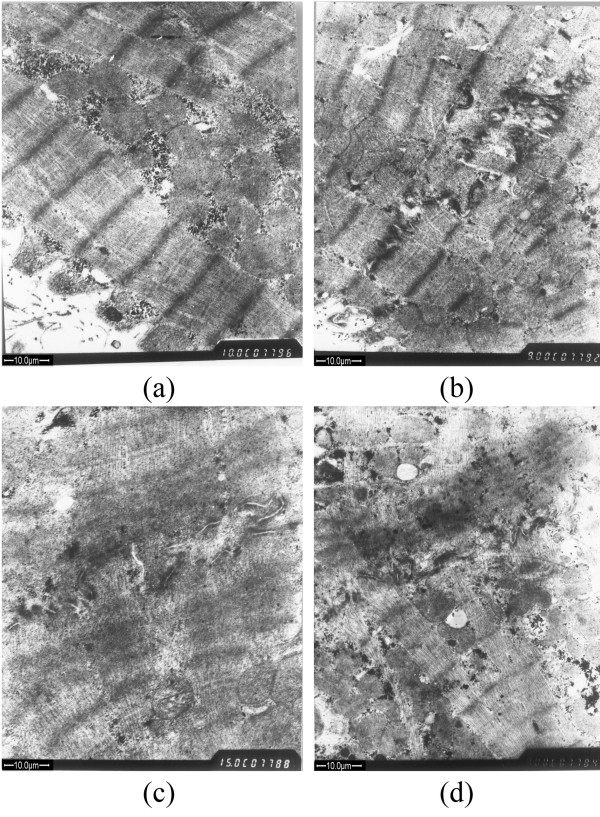
TEM micrographs of myocardium. (a) the healthy group; (b) group A; (c) group B; (d) group C.